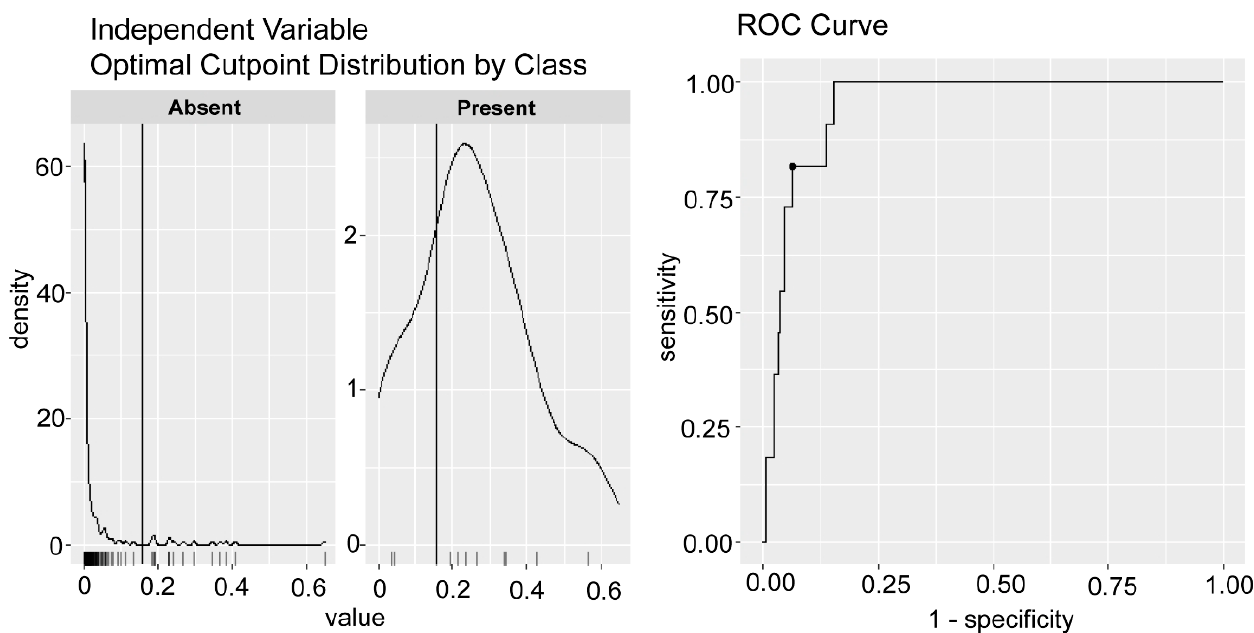
Figure 4. The AUC of the ROC for the best EEEV model. Table 4. The credible intervals for the WNV 95% confidence set. No variable had a strong effect on WNV seroconversion. The sign of the mean indicates a positive or negative effect. If values cross zero between the 0.025 quant and the 0.975 quant, the variable has no effect on